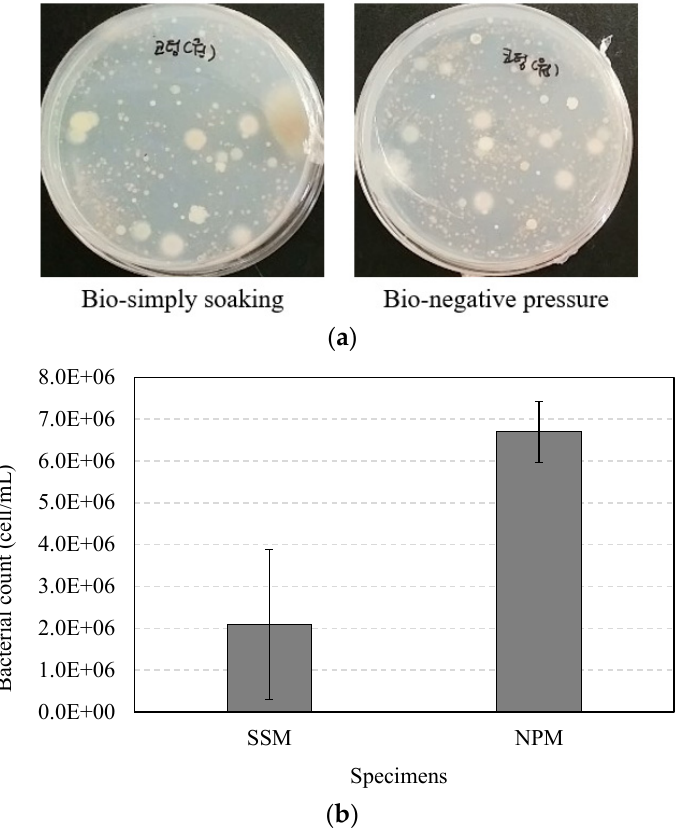
Figure 11. Results of the re-cultured bacteria from the coated concrete immersed in 5% sulfuric acid solution for 28 days: ( a ) re-cultured images; and ( b ) population of bacteria.